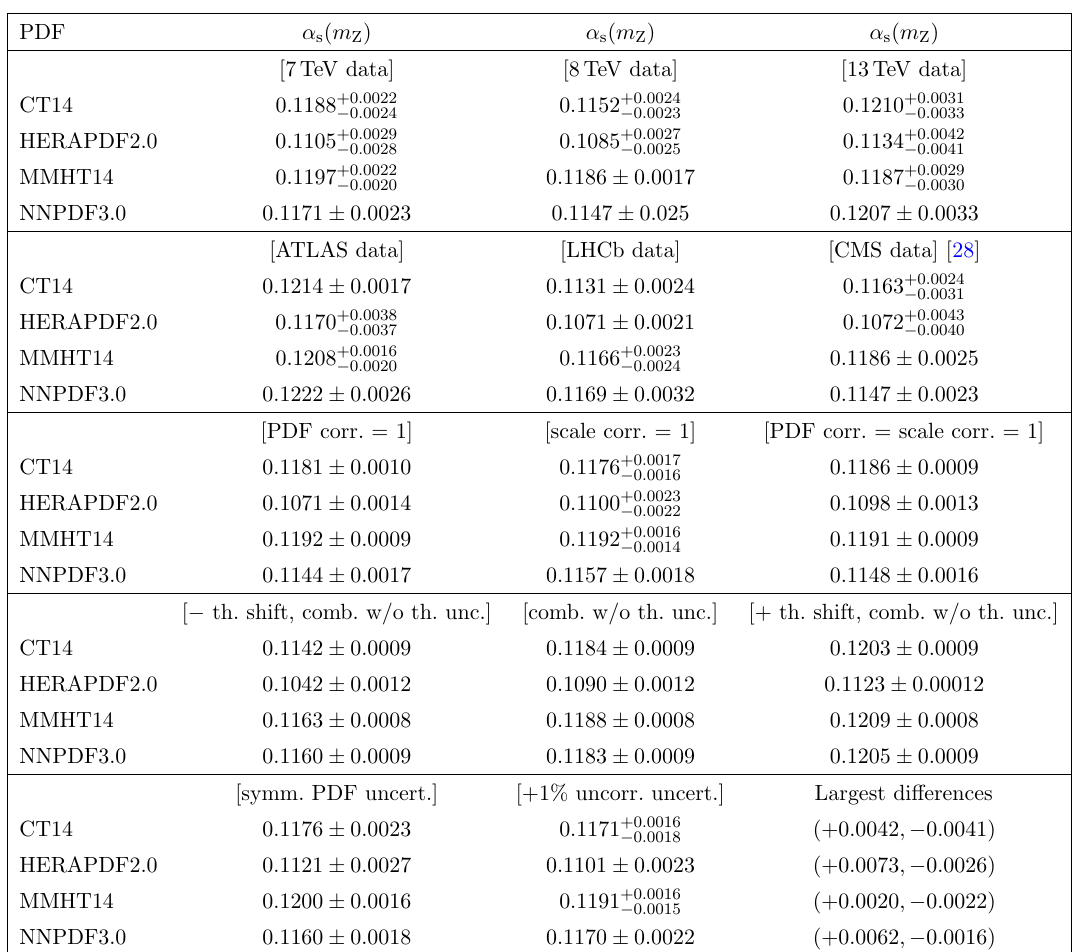
Table 14 . Sensitivity of the (cid:12)nal (cid:11) s ( m Z ) extractions per PDF set to various experimental and theoretical ingredients. Top row: when using only the 7, 8, and 13 TeV measurements separately. Second row: when combining only the data of each experiment. Third row: when considering the extreme case of all the PDF eigenvectors/replicas or/and the scale uncertainties as fully cor- related. Fourth row: when removing all theoretical uncertainties in the combination (center), and also (cid:12)rst subtracting from (left) or adding to (right) each of the 28 (cid:11) s ( m Z ) central values their corresponding quadratic sum of scale and PDF uncertainties. Bottom row: when symmetrizing the PDF uncertainties by taking the maximum of the negative and positive values (left), and when adding a 1% uncorrelated uncertainty to all cross sections (center), and largest di(cid:11)erences observed in the (cid:11) s ( m Z ) values per PDF set, compared to the original results in table 13, after all the above cross-checks